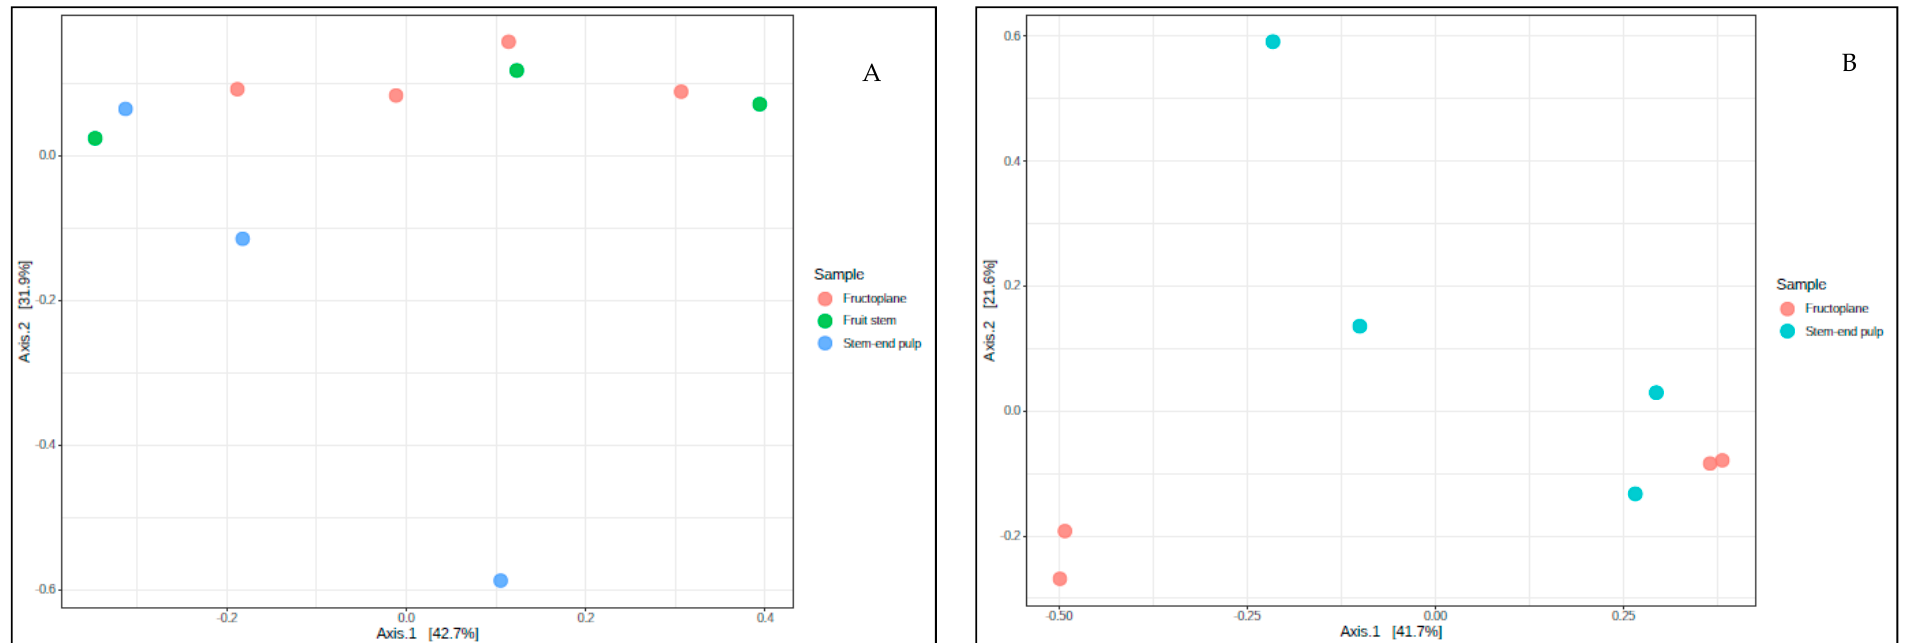
Figure 2. Principal component analysis of the mango fructoplane and stem-end pulp bacterial community compositions at the ( A ) pre-harvest and ( B ) post-harvest stages of cv. Tommy Atkins mangoes, according to Illumina sequencing data.